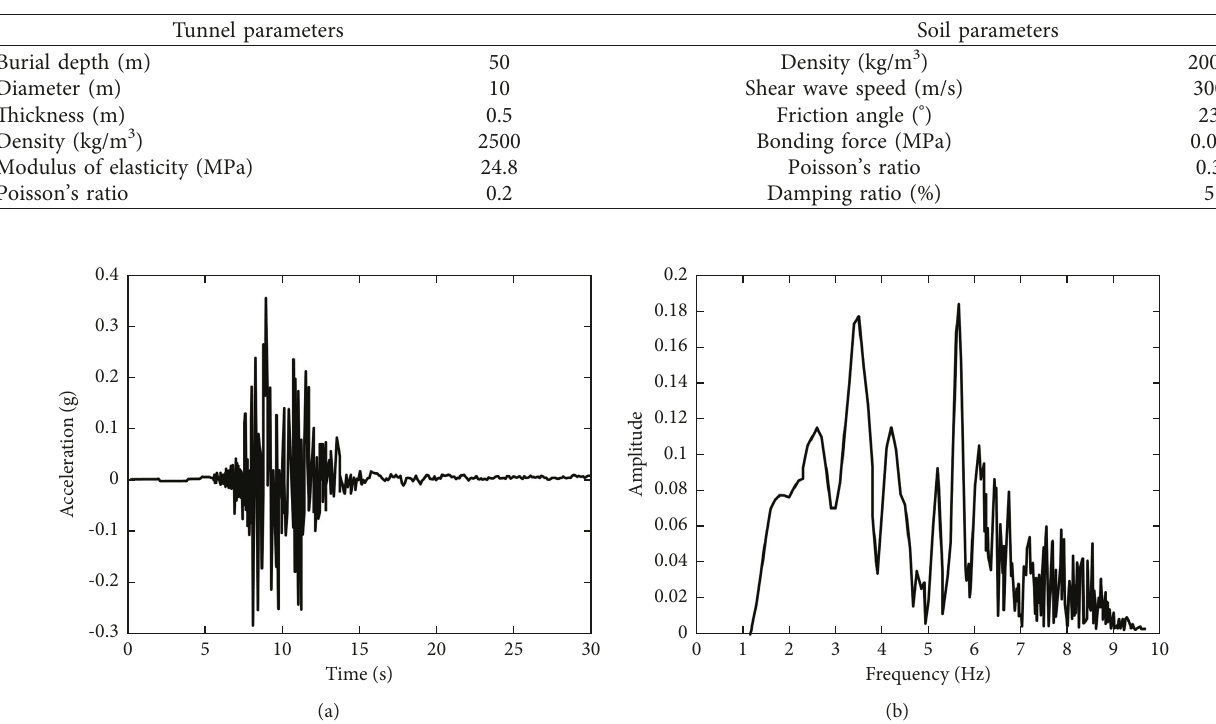
Figure 2: (a) Acceleration time history of South Iceland earthquake. (b) Power spectrum of South Iceland earthquake.